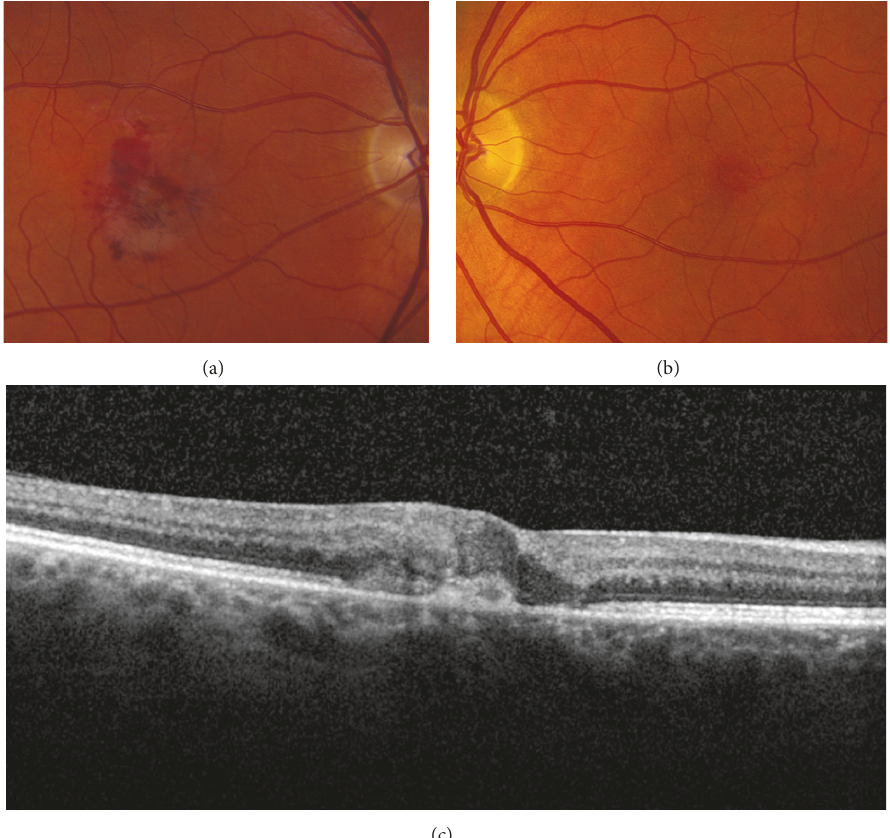
Figure 2: Fundus photography 2 years after initial presentation. (a) Macular hemorrhages are present in the right eye. (b) Stable foveal pigment mottling is present in the left eye. (c) SDOCT of the right macula reveals a subretinal neovascular membrane.